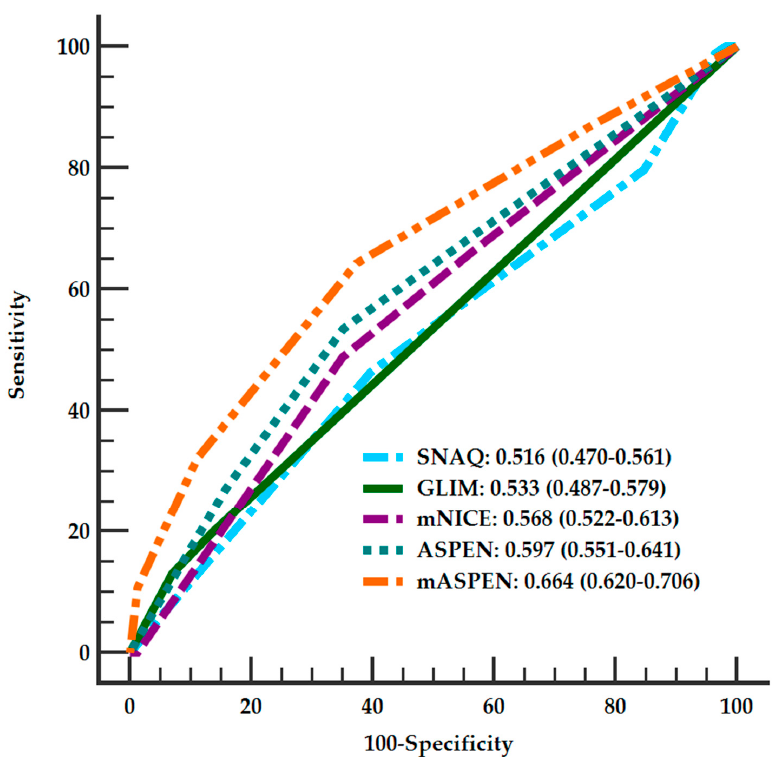
Figure 2. Receiver operating characteristic (ROC) curves of SNAQ, GLIM, mNICE, ASPEN, and